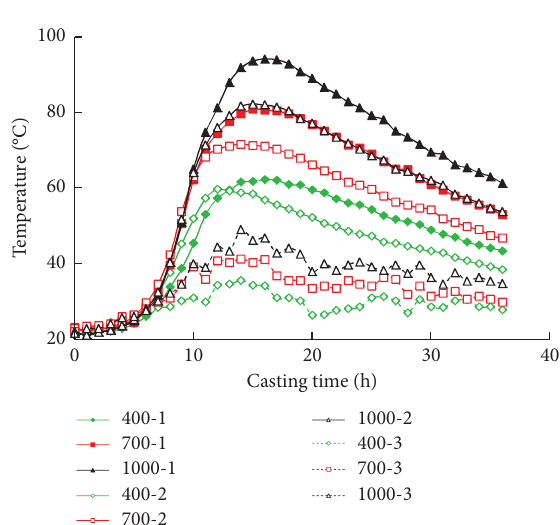
Figure 5: Relationship between temperatures and casting time (pure cement). Note: 400-1 denotes the value of the test with a casting density of 400 kg/m3 in position 1.